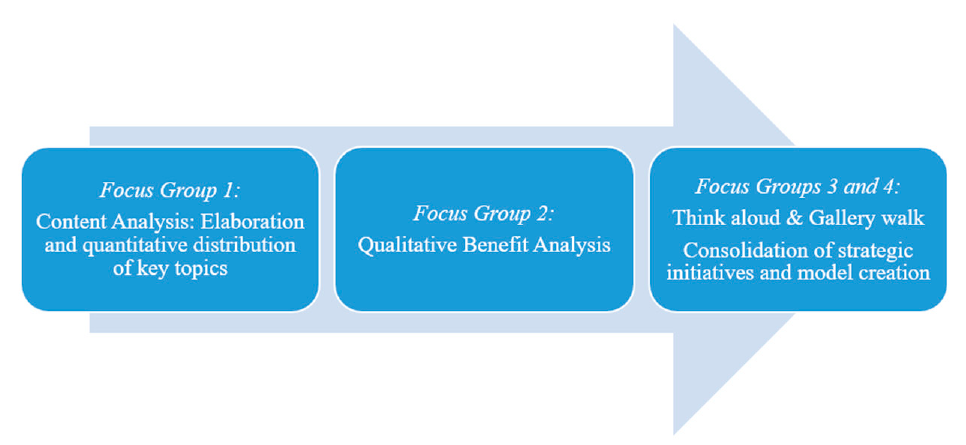
Figure 1: Methodological approach for developing a cross-border framework model for active and healthy ageing.